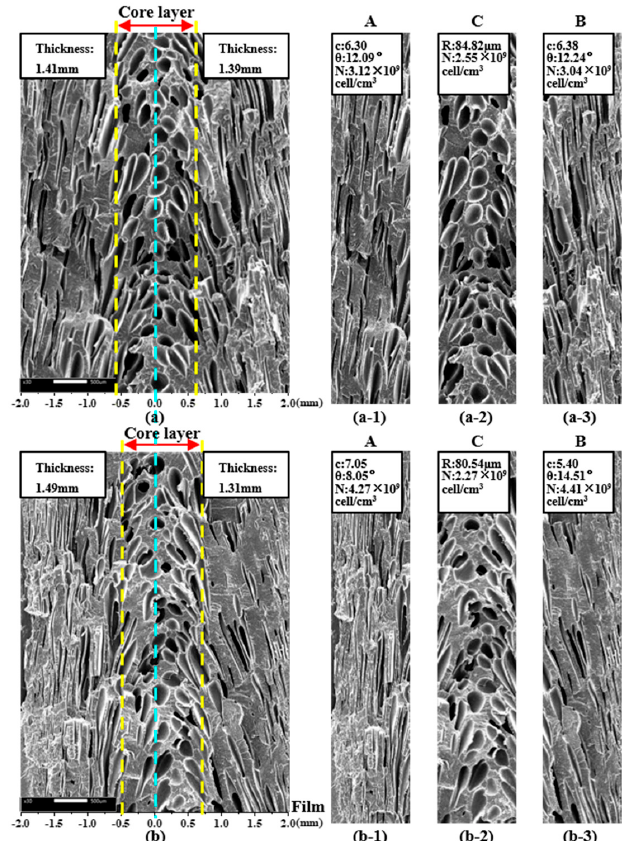
Figure 16. SEM micrographs of the parallel section of MIM and IMD/MIM samples: ( a ) and ( b ) the SEM micrograph of the parallel section of MIM and IMD/MIM samples, respectively; ( a-1 ), ( a-2 ), ( a-3 ) and ( b-1 ), ( b-2 ), ( b-3 ) the SEM micrographs of the transition layer A, core layer C and transition layer B of the parallel section of MIM and IMD/MIM samples, respectively.